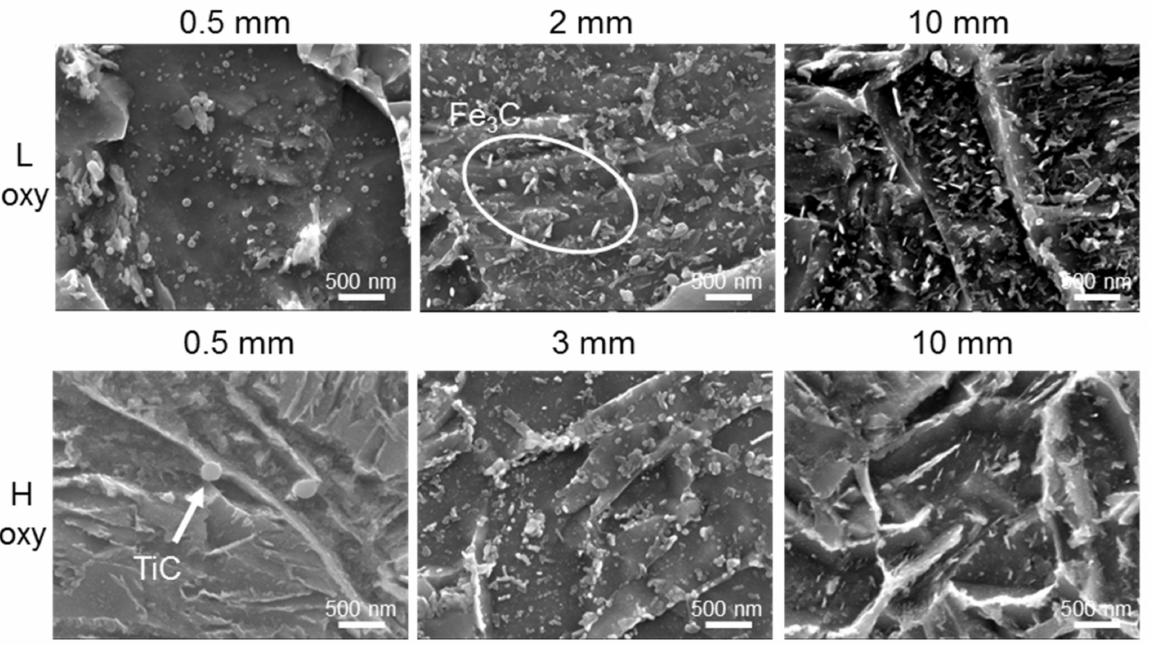
Figure 9. SEM images of fine precipitates in Steels L and H cut using oxy-fuel cutting method: left to right, at the cut edge, point of minimum HV, and far away from the cut edge (base